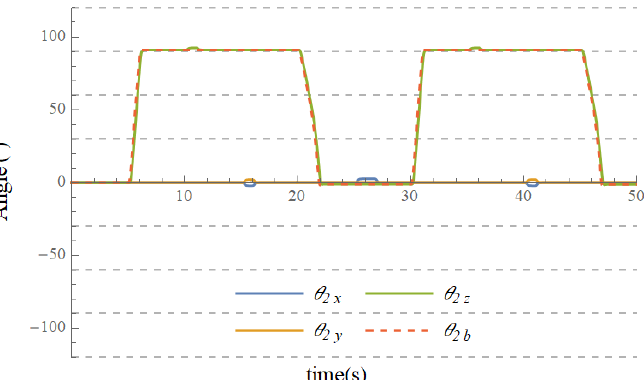
Figure 11. Evolution of Rotation Vector 2 when testing the link model using only encoder measurements.